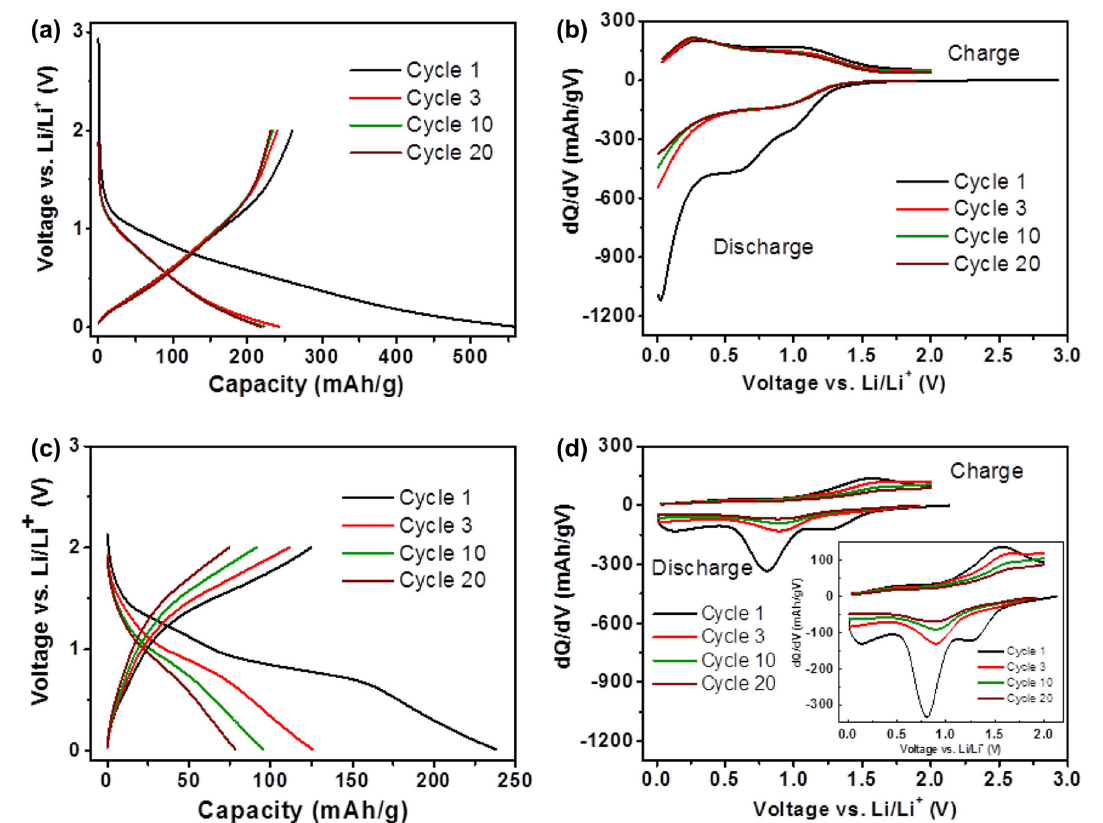
Fig. 5 Electrochemical behavior of the nanostructured electrodes. Galvanostatic curves of: a Fe-nanocarbon composite electrode, and c as-deposited Fe nanoparticle electrode. Differential capacity curves